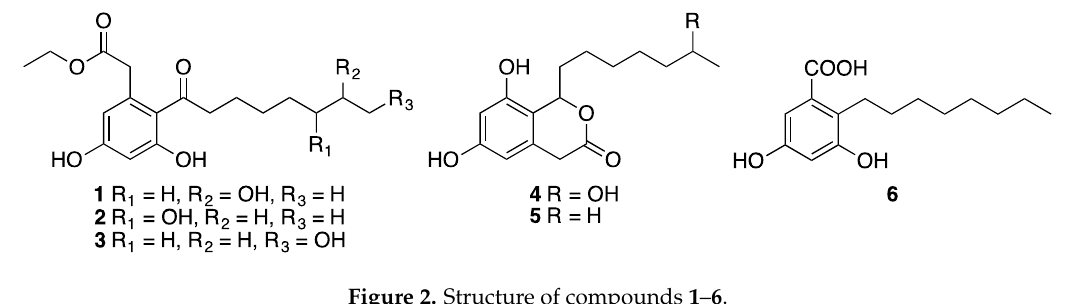
Figure 2. Structure of compounds 1 – 6 . Table 1. Antiviral activity of Compounds 1 – 6 (500 µ g/mL) against TMV.